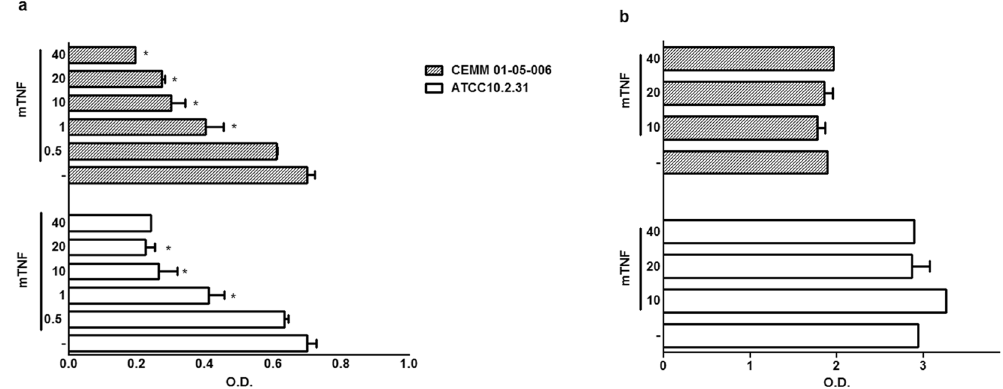
Figure 1. Effect of TNF on biofilm formation by C. albicans . Murine tumor necrosis factor (mTNF ng/mL) or medium ( − ) were added to growing ( a ) or mature ( b ) biofilms of two strong biofilm producers C. albicans strains. Biofilm metabolic activity was assessed using the XTT reduction assay. Data represent the mean ± SEM (Absorbance 492nm ) of two independent experiments conducted in triplicate; * P < 0.001 as compared to